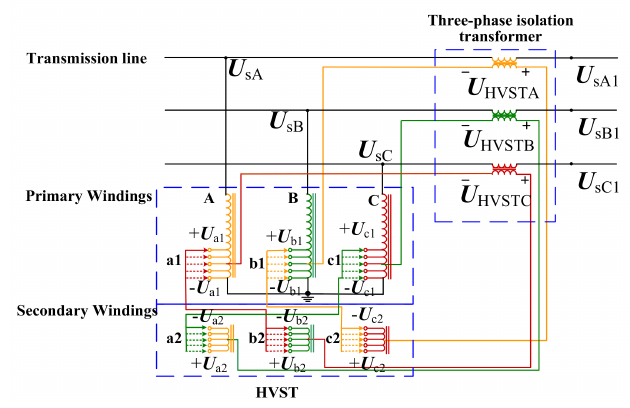
Figure 2. High-voltage “Sen” transformer (HVST) configuration.